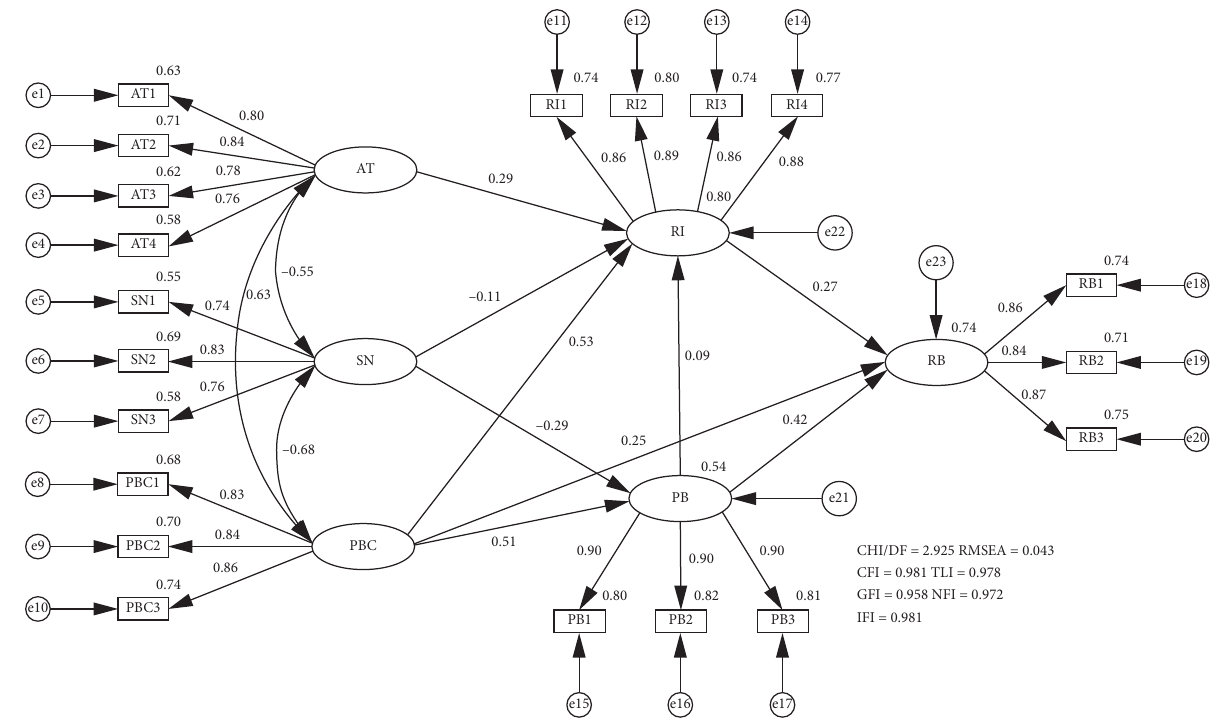
Figure 4: The modified TPB model for e-bikers’ RLR